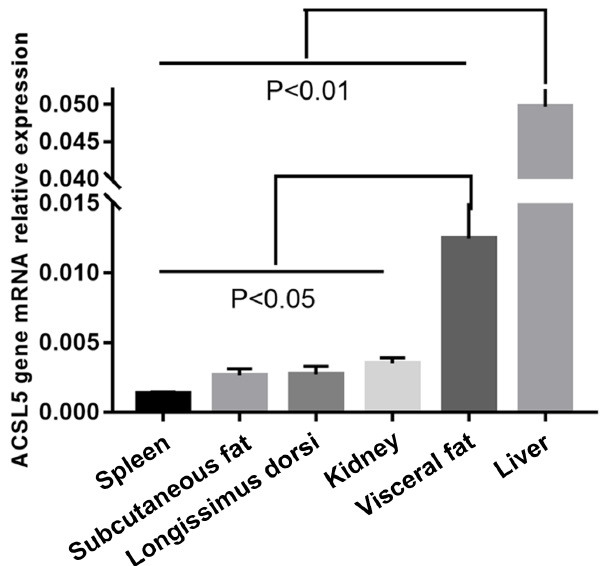
Figure 1. The abundance of ACSL5 in six bovine